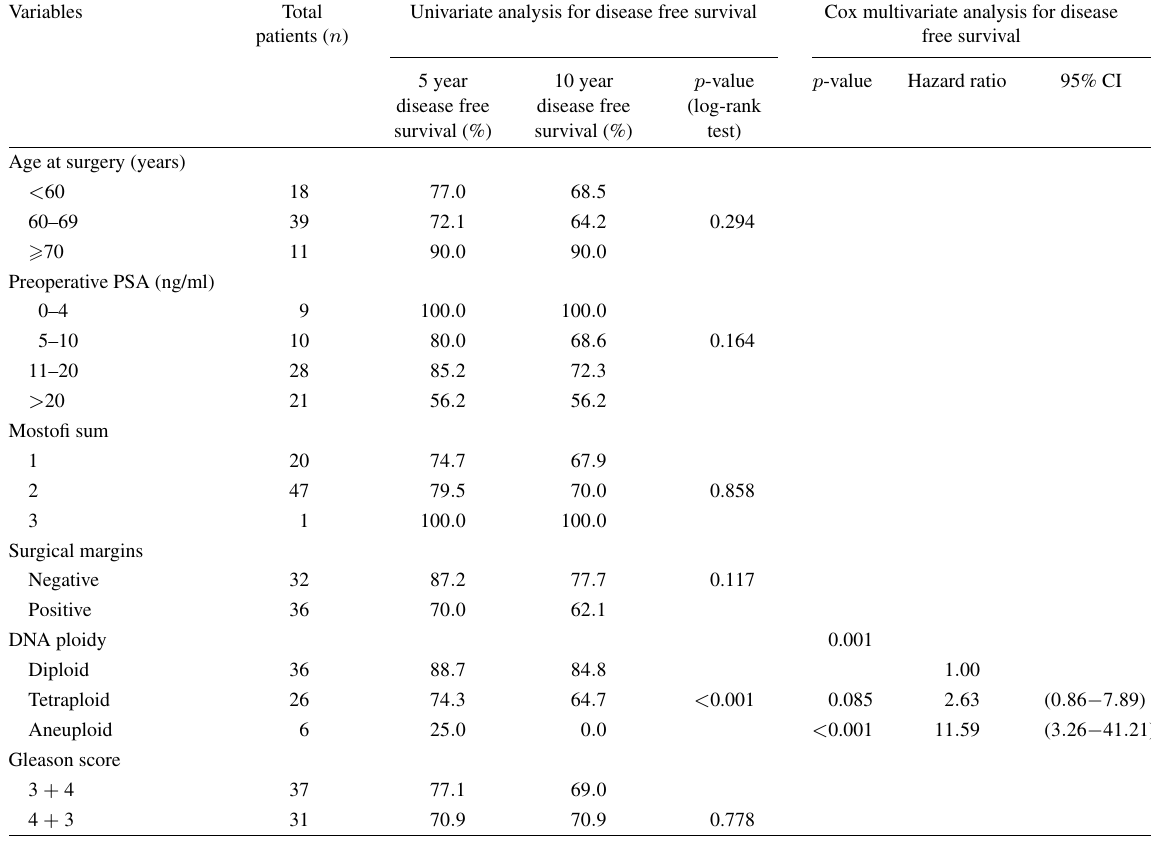
Disease free survival related to prognostic factors for Gleason score 7 patients